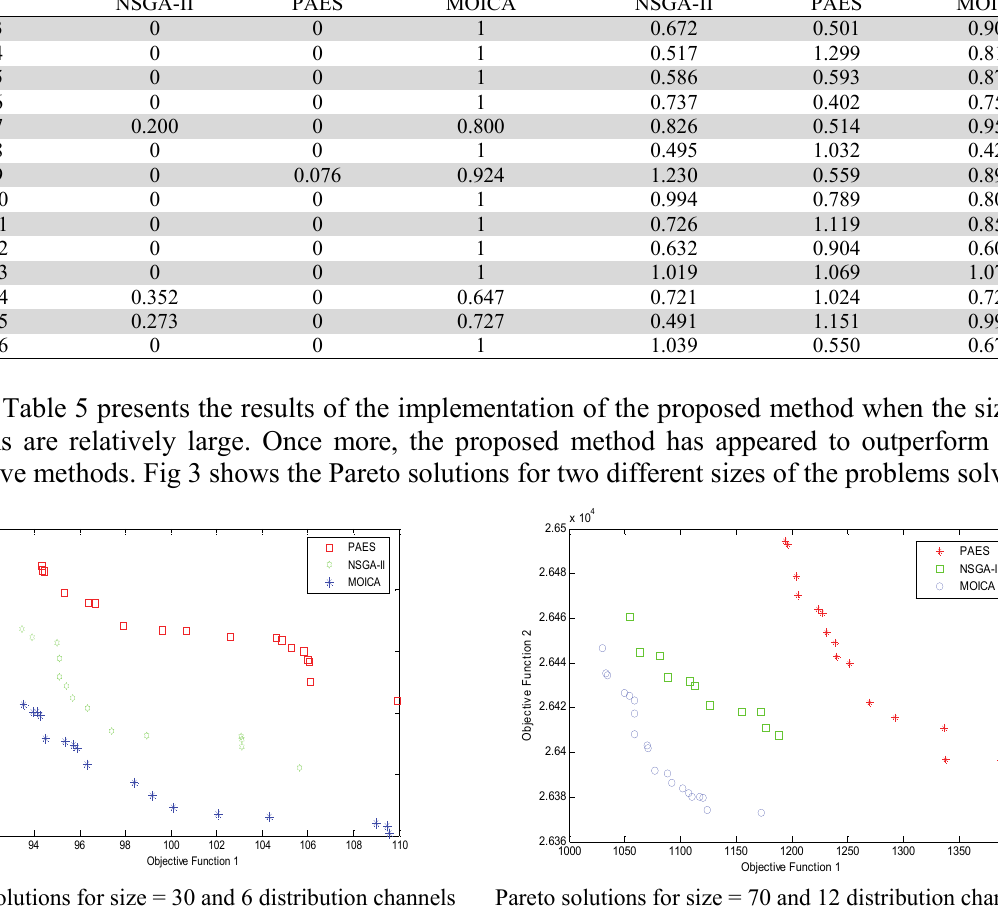
Fig. 3. The results of the Pareto solutions for small and large